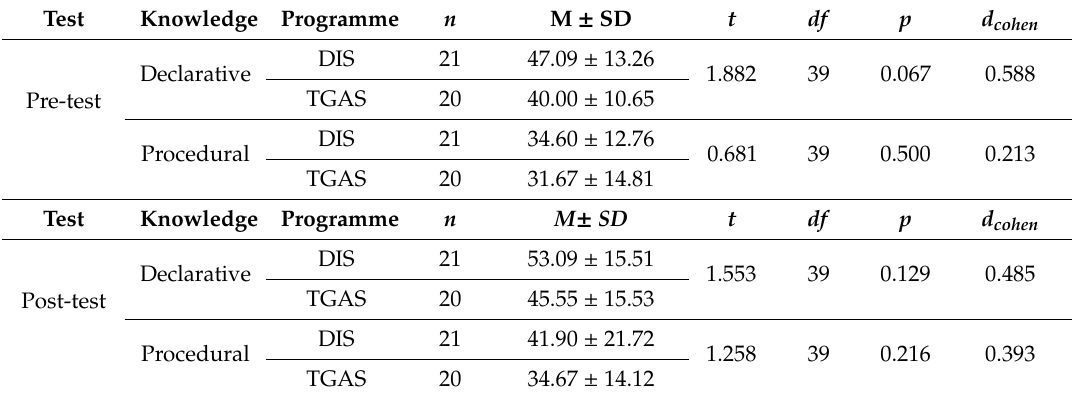
Table 4. Level of declarative and procedural knowledge between both class groups in the pre-test and post-test.